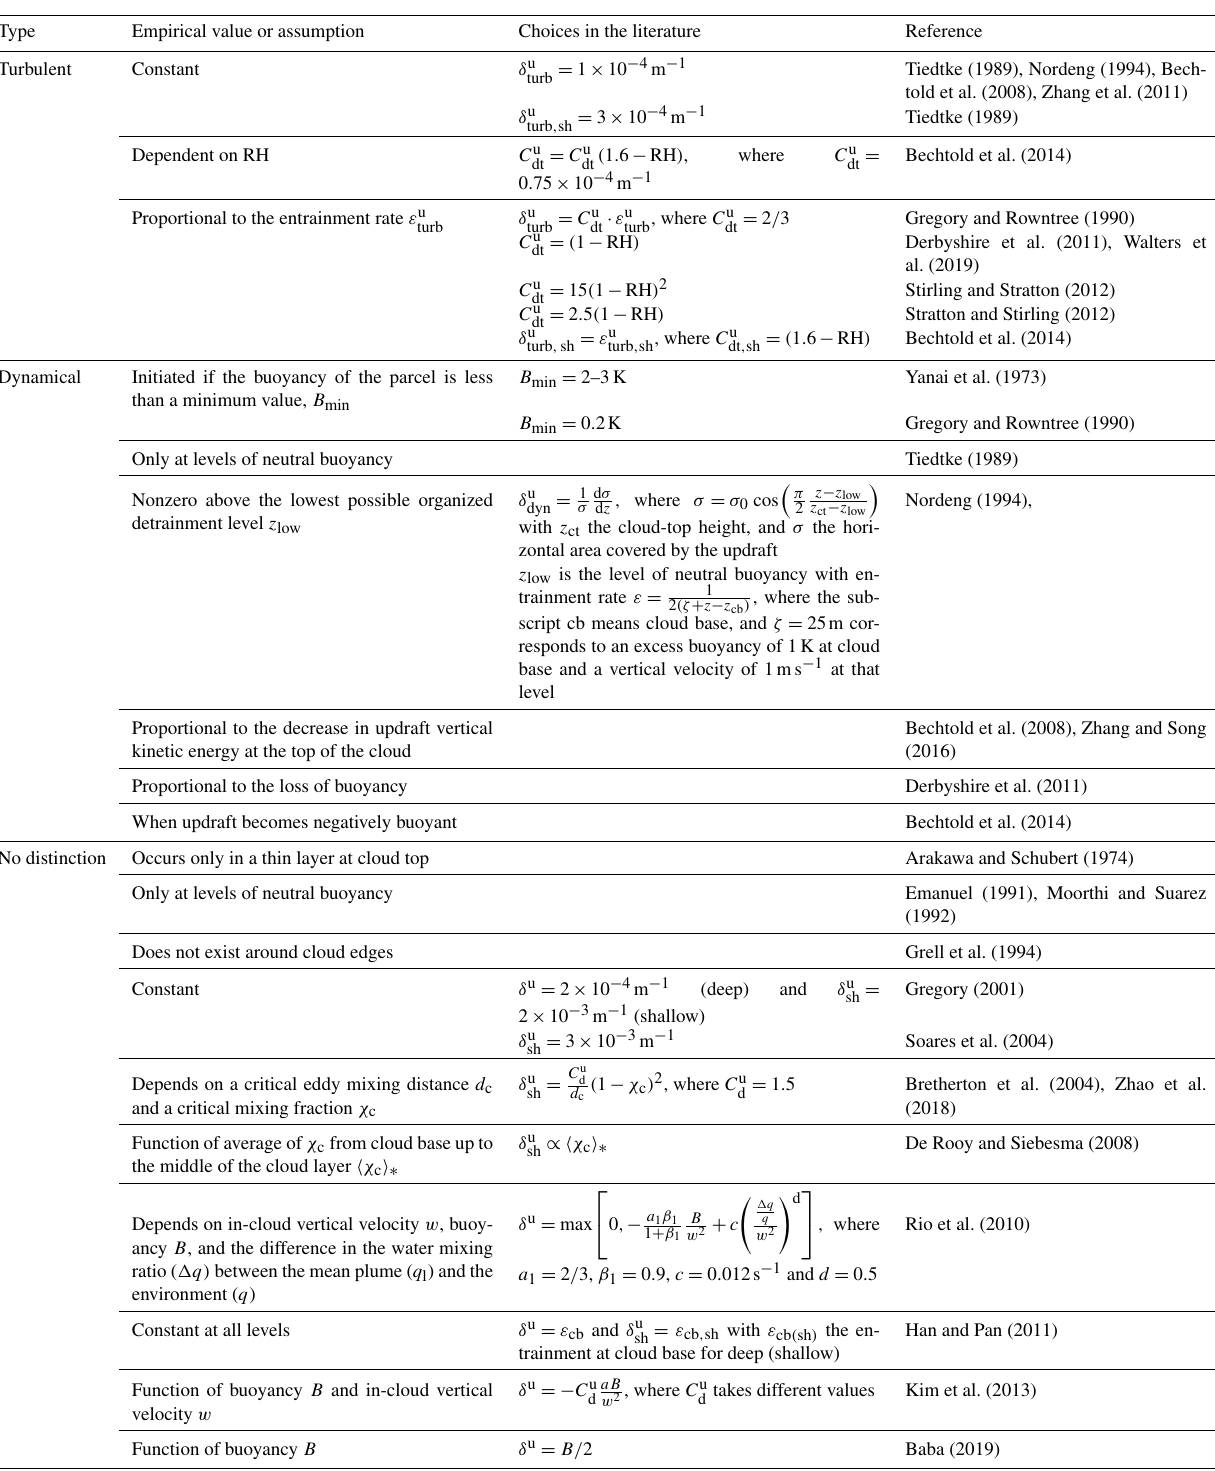
Table 7. A sample of empirical values and assumptions used in the parameterization of detrainment in the updraft (note: subscript “sh” refers to shallow